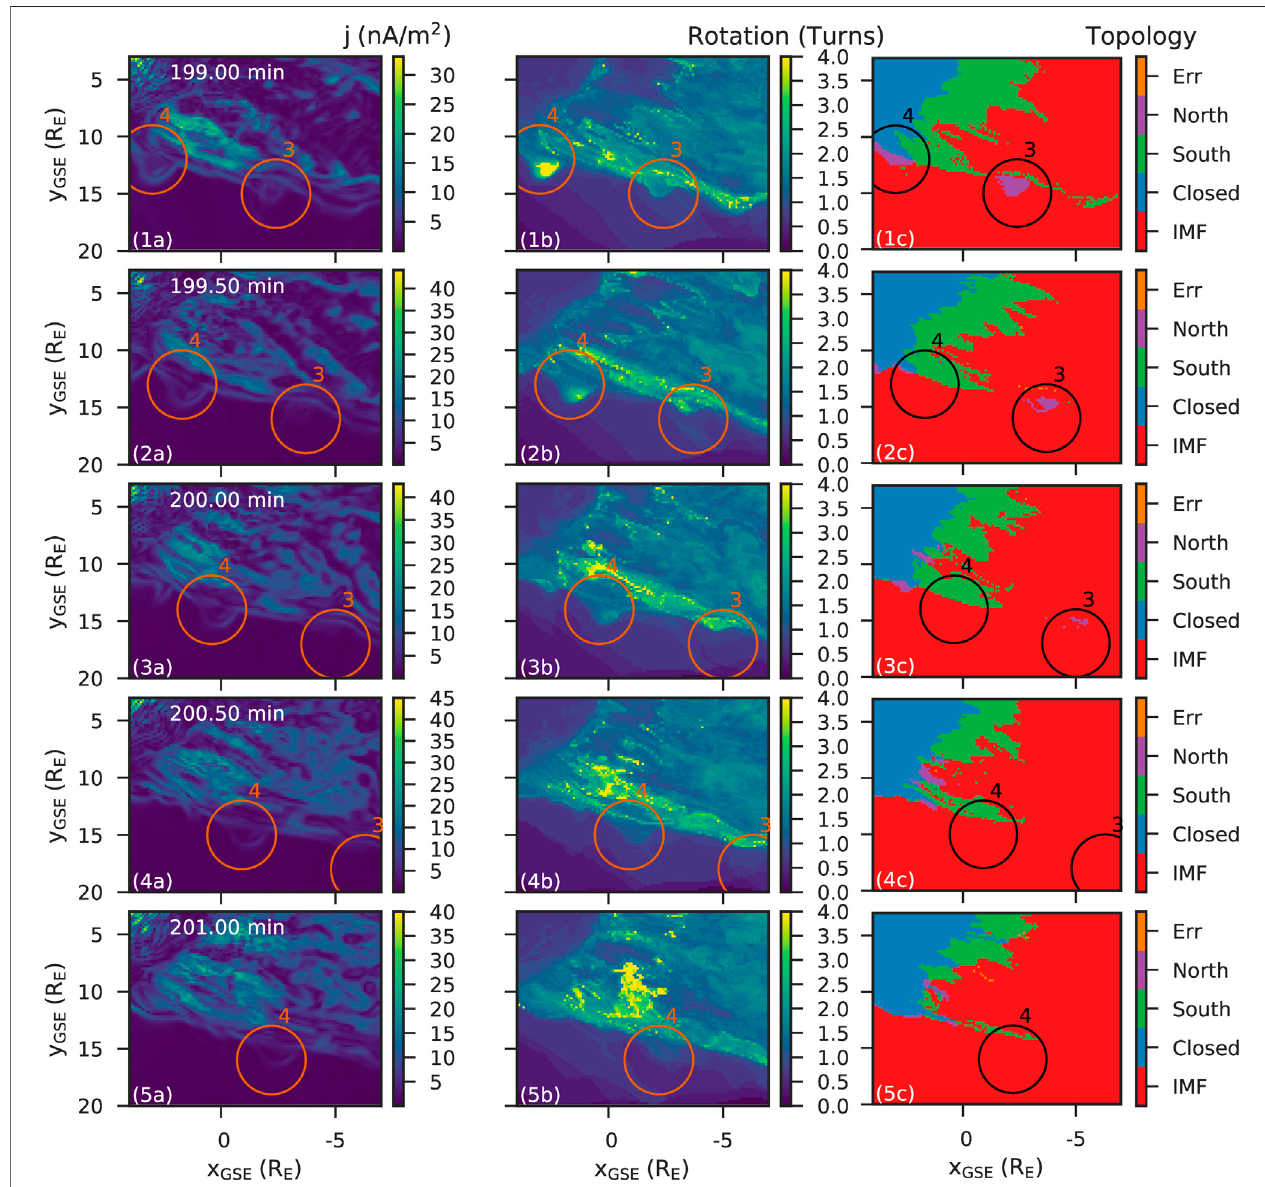
FIGURE 9 | The dissipation of fl ux ropes past the nightside reconnection region. Each panel shows a slice in the ecliptic plane z GSE (cid:2) 0. With each row, time increases by 30 s. The left column (A) shows current density magnitude, the middle (B) the total rotation of the magnetic fi eld, and the right (C) the magnetic topology.